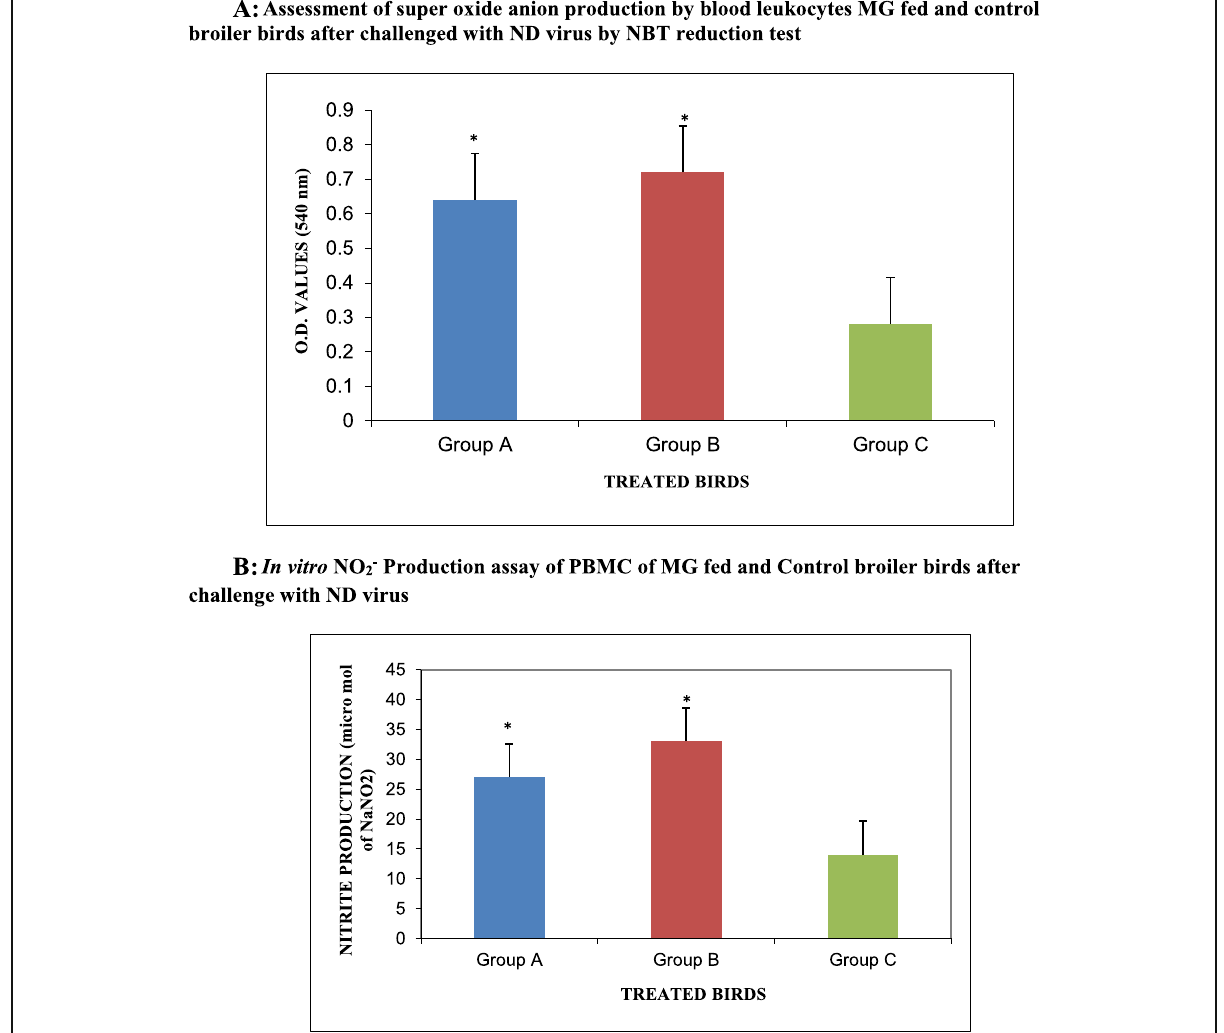
Fig. 2 a Assessment of super oxide anion production by blood leucocytes of MG-fed and control broiler birds after challenge with RD virus by NBT reduction test. b In vitro NO 2 − Production assay of PBMC of MG-fed and control broiler birds after challenge with RD